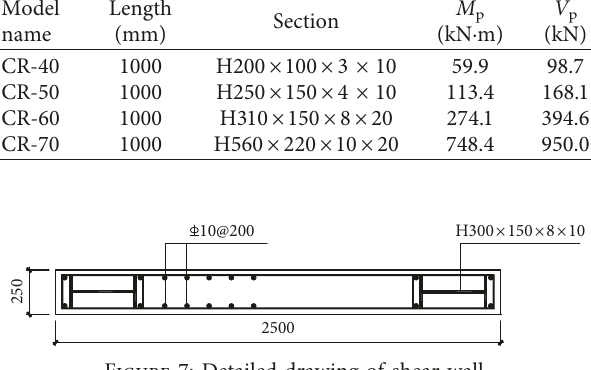
Figure 7: Detailed drawing of shear